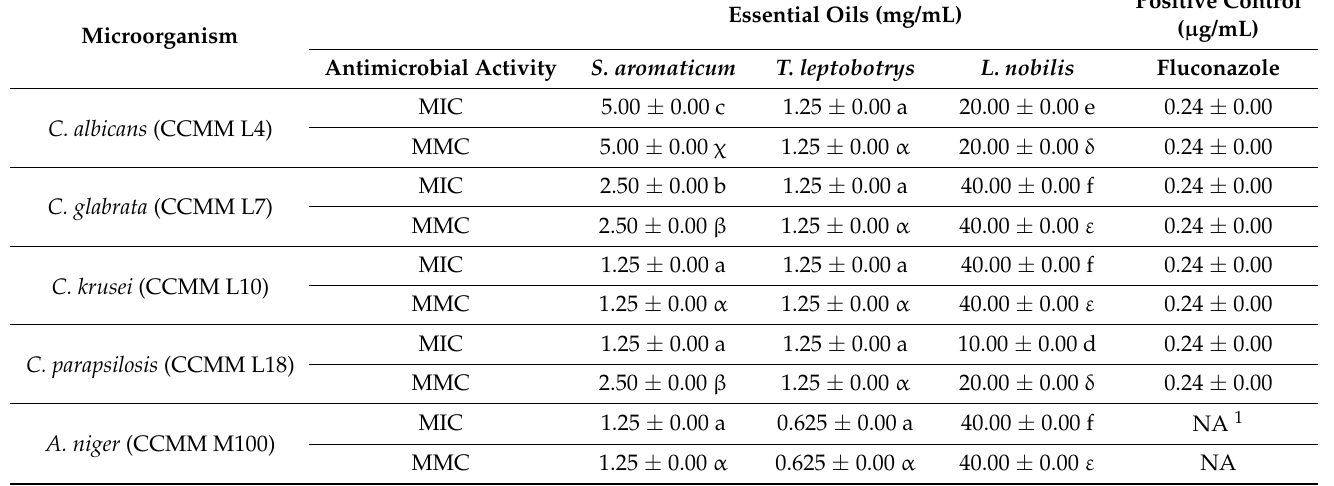
Table 3. Minimum inhibitory concentration (MIC) and minimum microbicidal concentration (MMC) of essential oils against fungal strains.